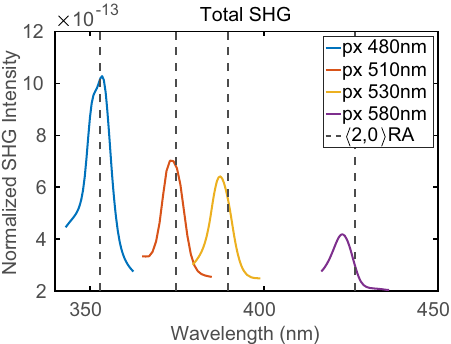
Figure 10: (Color online) Intensity of the second harmonic signal generated for different p x spacing. The dashed lines show the 〈 2 , 0 〉 Rayleigh anomaly